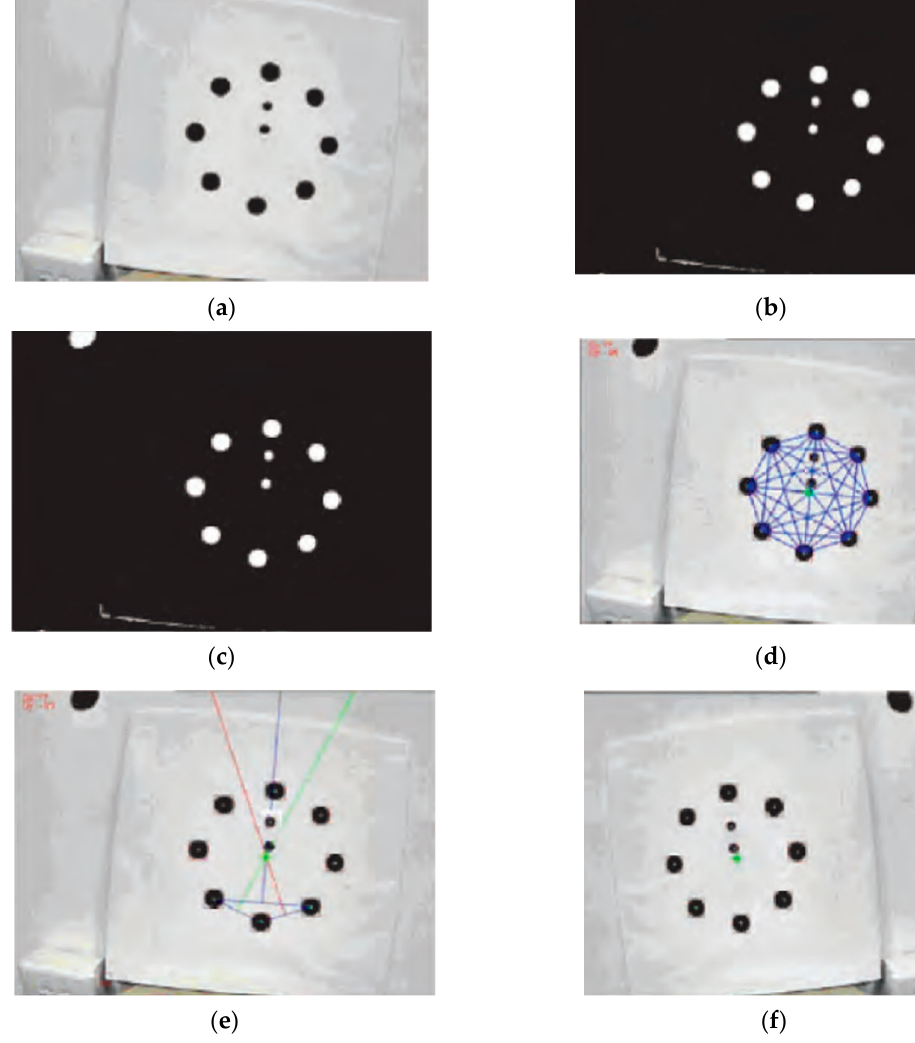
Figure 4. Image analysis results: ( a ) original image, ( b ) binary image, ( c ) target recognition, ( d ) target center detection, ( e ) target center estimation, ( f ) target orientation estimation.